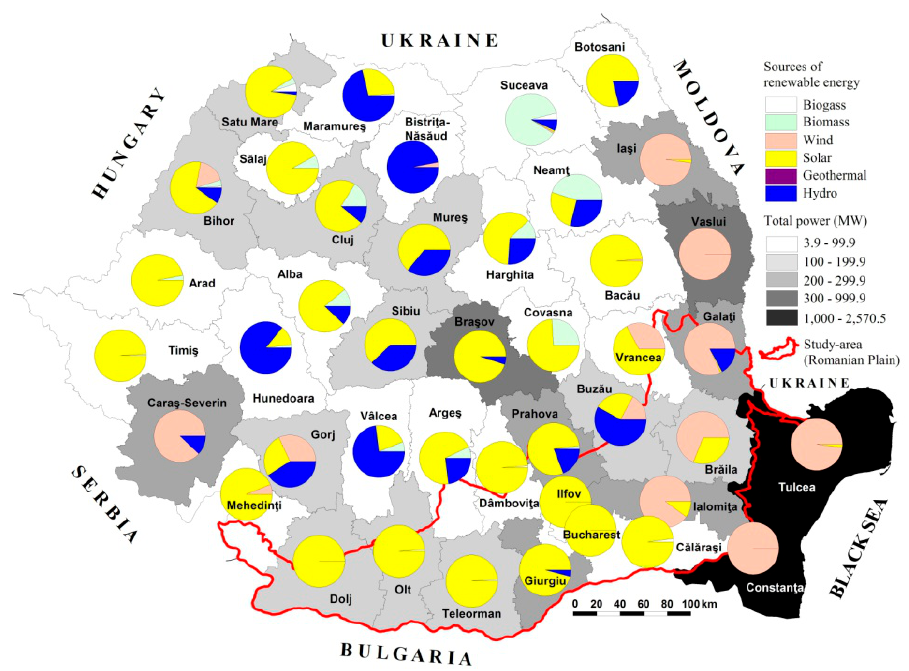
Figure 1. The use of renewable energy sources in Romania (2018) at the county level. (Source: data processed after [34]). (Note: for hydro power, only hydroelectric plants that appear after 2009 are listed).